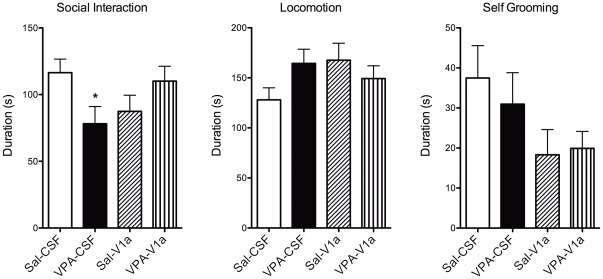
Social interactions and other behaviors in rats pre-exposed to saline (Sal) and valproic acid (VPA) during gestation.Measurements were taken immediately before setup for fMRI studies and 60 minutes after an intracerebroventricular (ICV) injection. Experiments tested whether VPA altered social behavior and neural processing, and if this involves an altered role for the V1a receptor. Thus, Sal and VPA rats were subdivided into animals that were given an ICV injection of Sal or a vasopressin V1a receptor antagonist. The groups are: Sal-CSF (open bar), VPA-CSF (close bar), Sal-V1a (diagonal patterned), and VPA- V1a (upward patterned). Data shown as mean ± standard error. VPA rats showed lower social interaction (left) and trended towards higher locomotor activity (p = 0.07). *Significantly different from Sal-Sal (p<0.05; two way ANOVA).